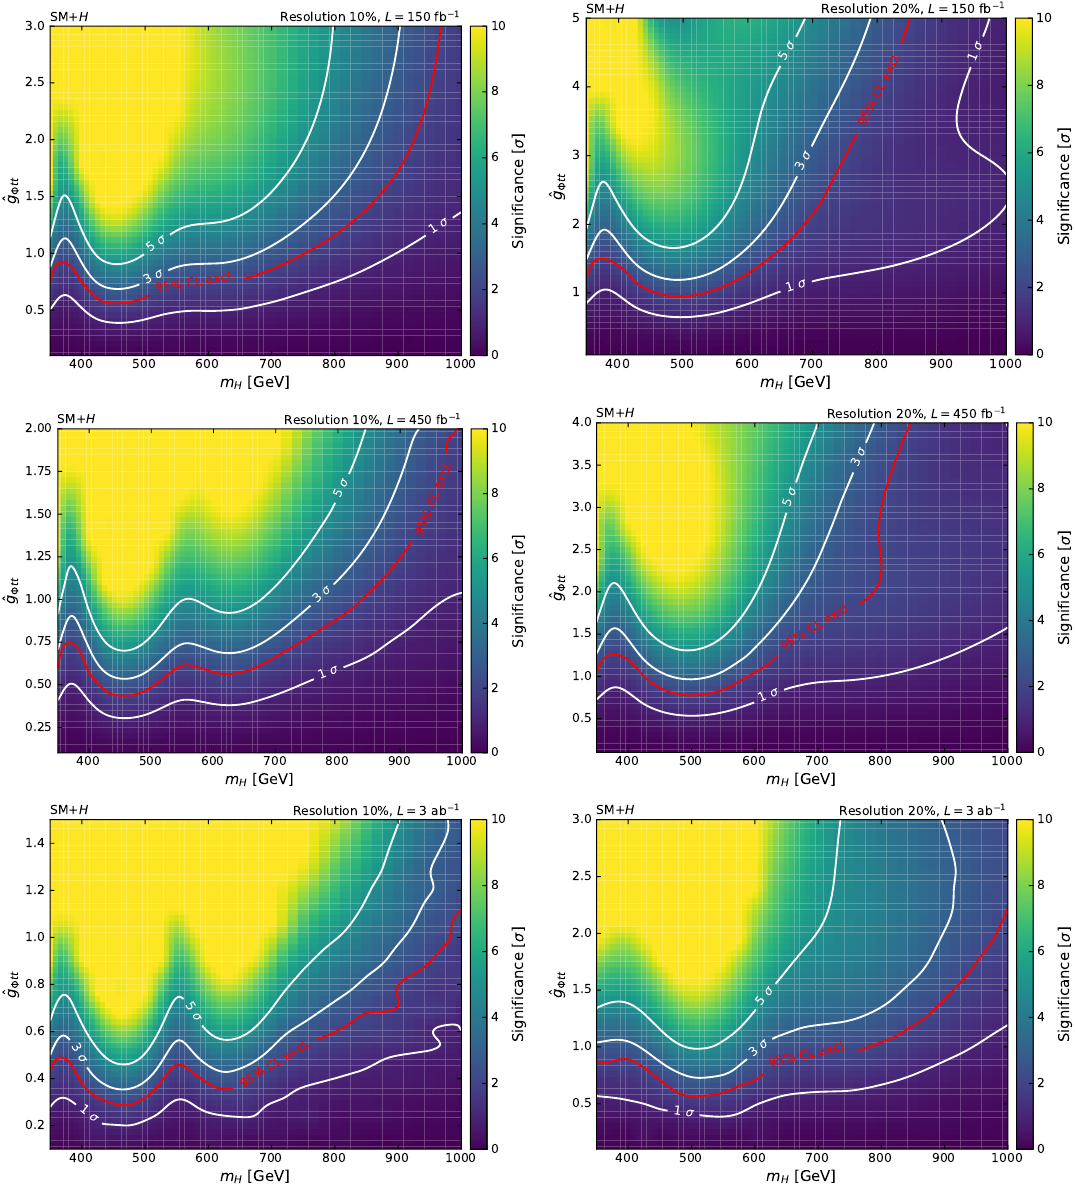
Figure 10 . Expected signi(cid:12)cance and exclusion potential for the SM + H model in the same six experimental scenarios of (cid:12)gure 10. Values of signi(cid:12)cance in excess of 10 (cid:27) are